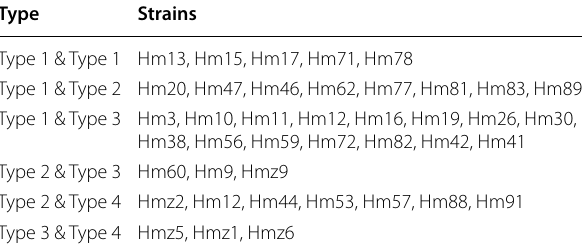
Table 1 Dikaryotic strains of H. marmoreus containing